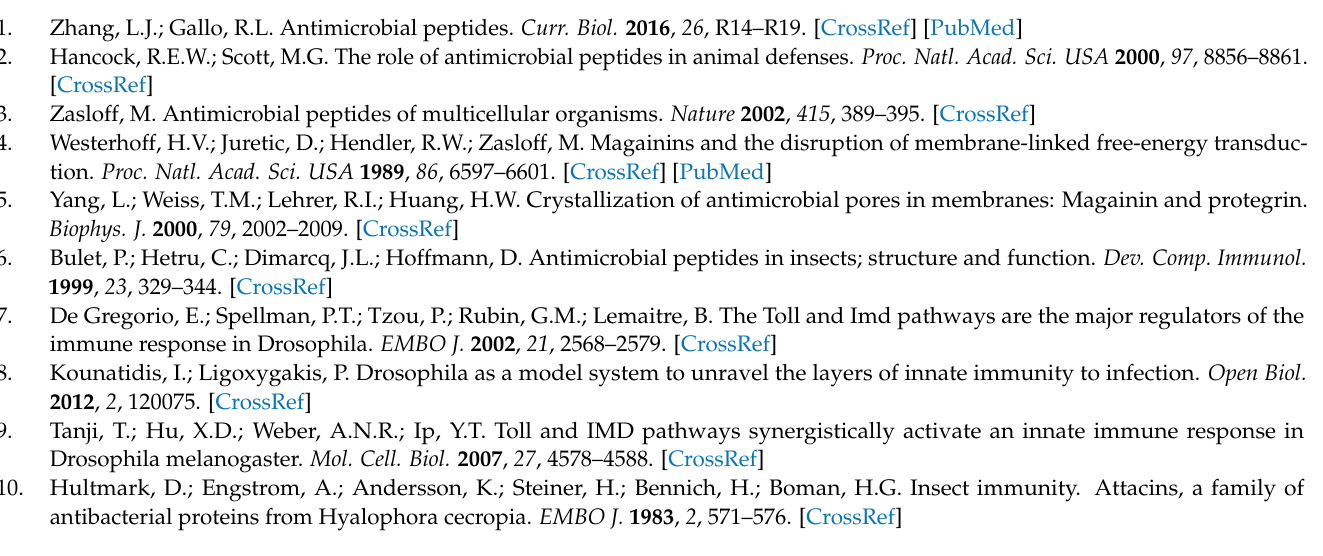
phylogenetic tree, Figure S3: L. longipalpis defensins alignment, Figure S4: Defensin phylogenetic tree, Figure S5: Gene silencing in sucrose-fed and infected females, Table S1: oligonucleotides used in this study, Table S2: L. longipalpis defensins